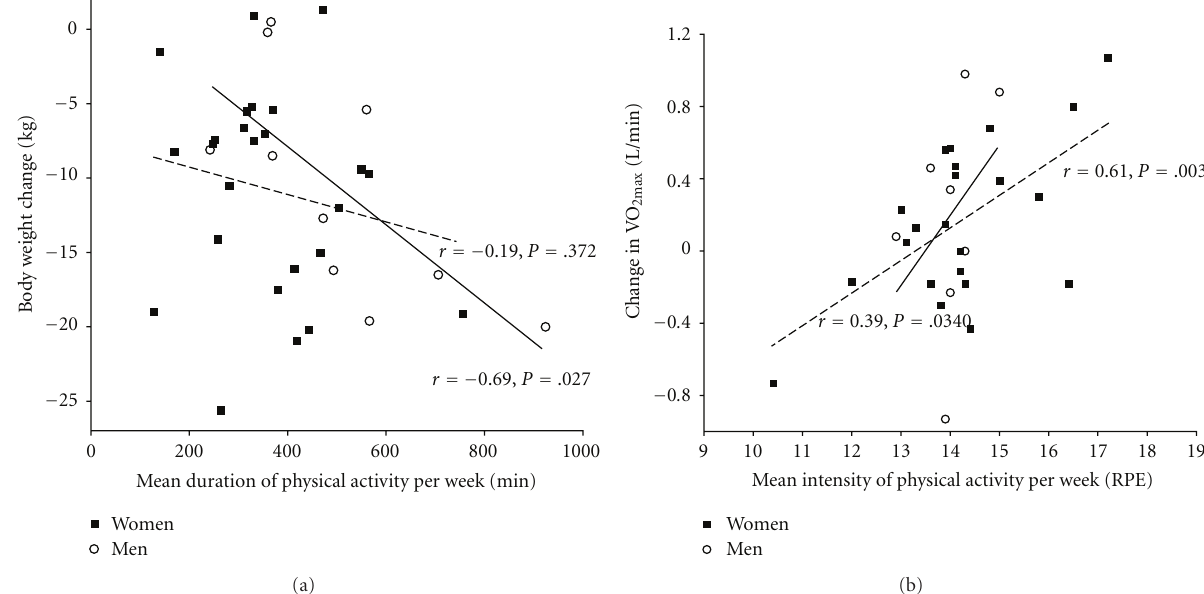
Figure 2: (a) Scatterplot showing weight change versus duration of physical activity for men (full regression line) and women (dotted regression line). (b) Scatterplot showing change in cardiorespiratory fitness versus intensity of PA for men (full regression line) and women (dotted regression